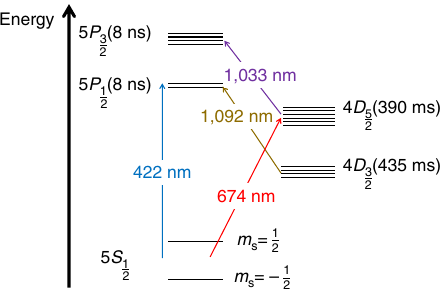
Figure 1 | Schematic diagram of atomic levels. 88 Sr þ ion relevant level scheme, levels lifetime and laser